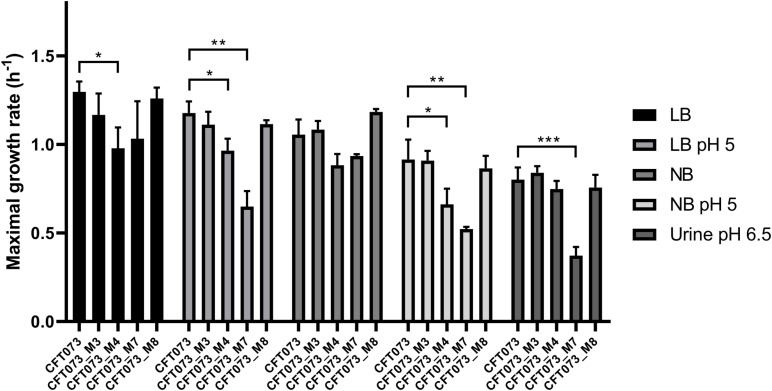
Maximal growth rates of CFT073 and in vitro mutants in Luria–Bertani (LB), LB pH 5, Nutrient broth (NB), NB pH 5 and urine (pH 6.5). Statistical comparison was performed using the unpaired t-test. *P < 0.05; **P < 0.01; ***P < 0.001.